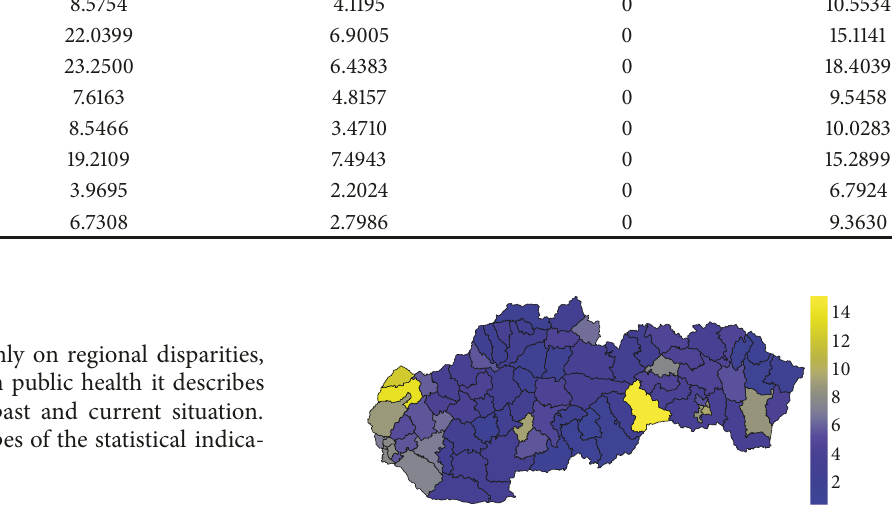
Table 2: The elementary statistics for the male sex standardised mortality rate according to the regions. district mean variance interquartile range